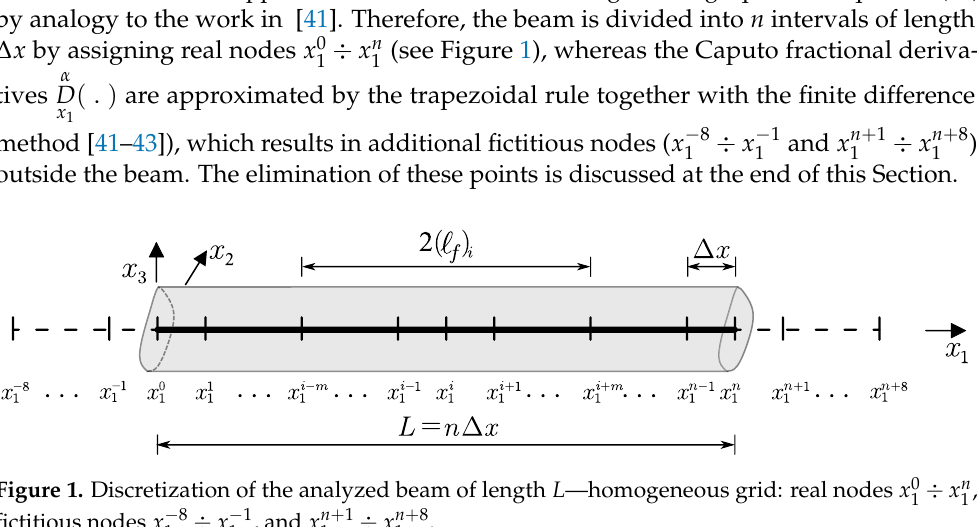
÷ x − 1 ÷ x n + 8 , and x n + 1 1 1 1 1